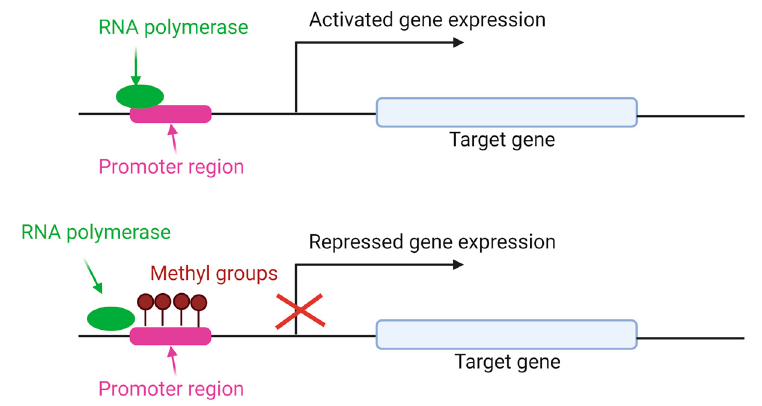
Figure 4. Gene expression regulated by DNA methylation. DNMT enzymes add methyl groups in cytosine residues of CpG island. As a result, RNA polymerase is unable to bind to the DNA sequence of the gene promoter and the gene expression is repressed [57].